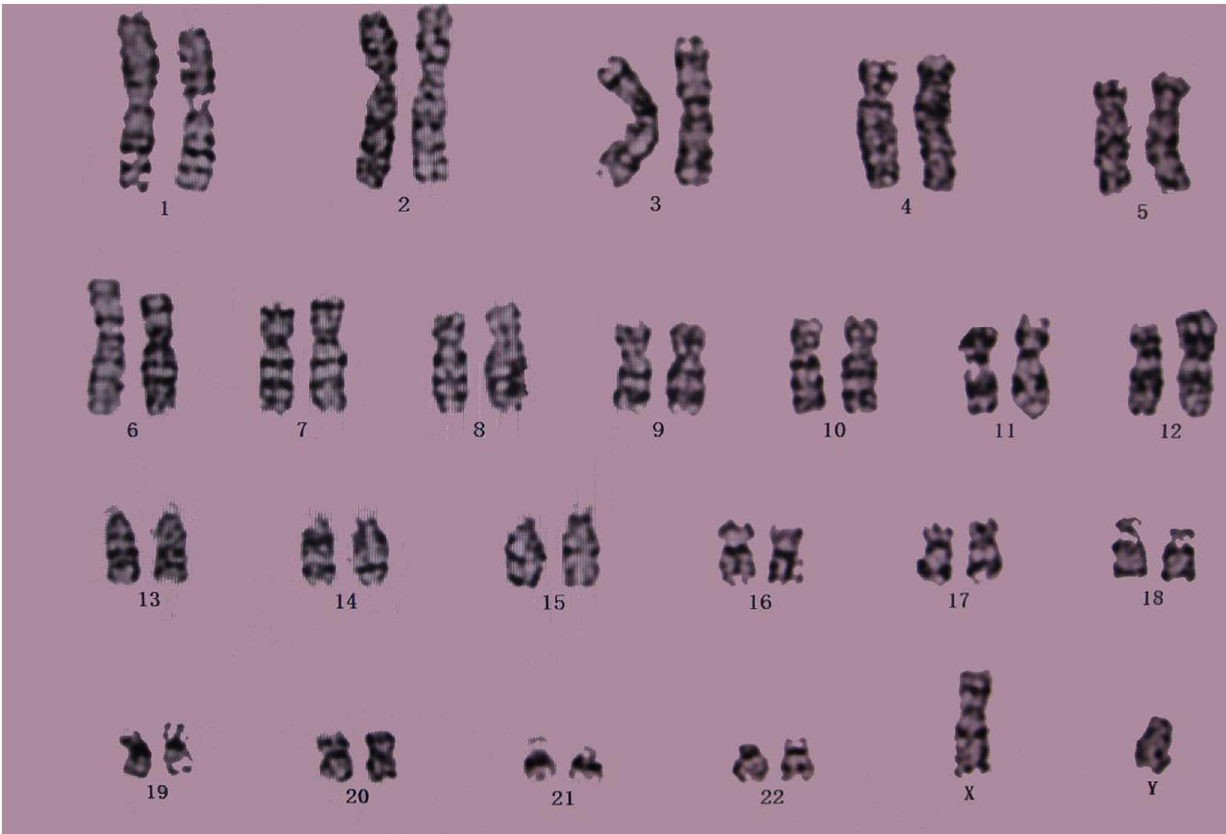
Figure 6. A conventional karyotype analysis performed at the 15 th passage (46,XY). The MSCs expanded in vitro did not show chromosome elimination, displacement, or imbalances.